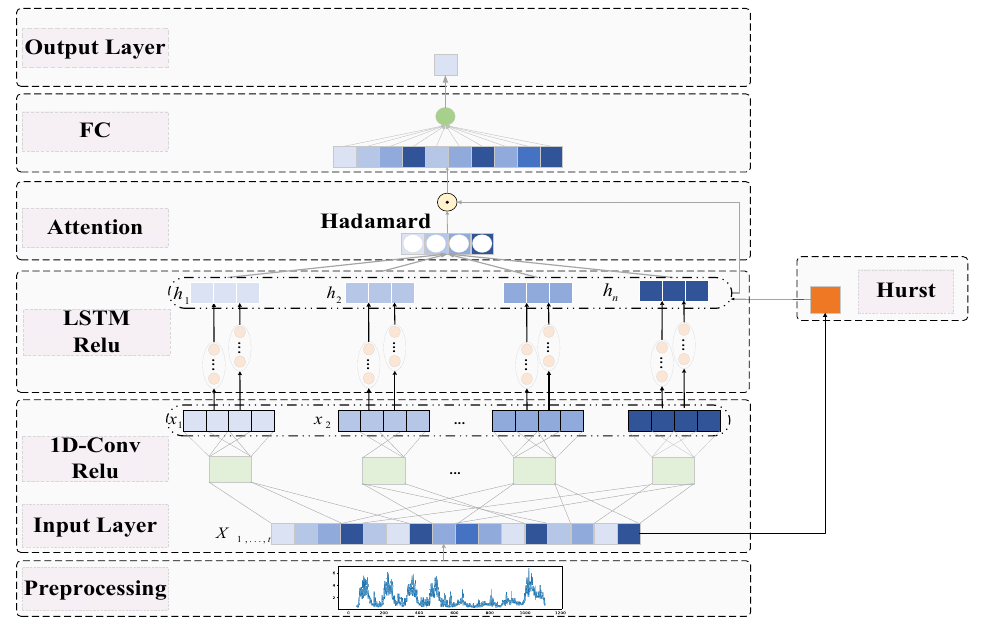
Figure 2. Network traffic prediction framework incorporating prior knowledge (FPK-Net).